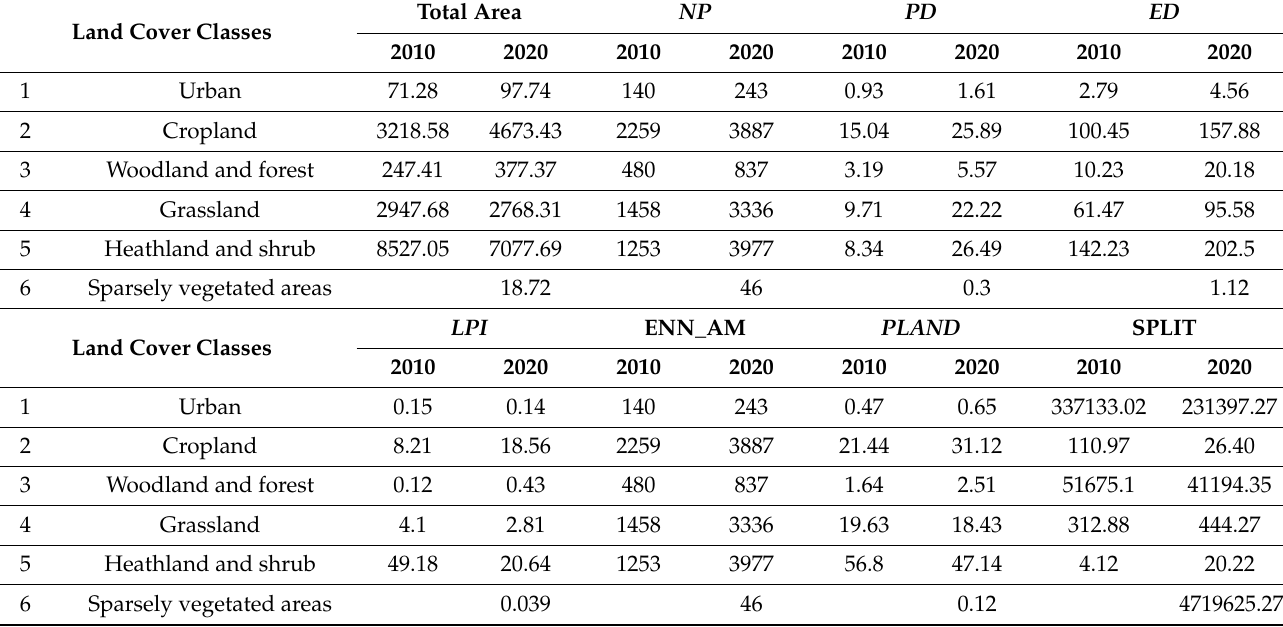
Figure 22. Classified LULC maps of Paleochora for 2010 ( left ) and 2020 ( right ). Table 11. Results for the landscape